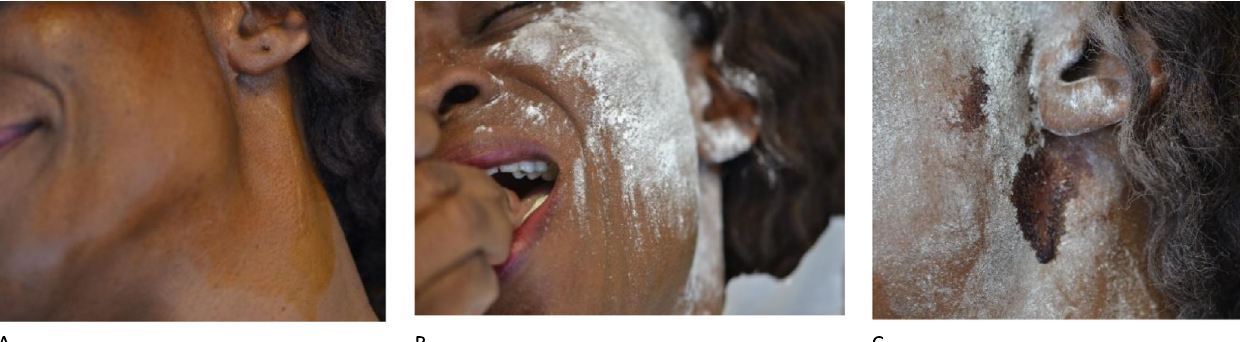
Fig. 5. A 36-year-old patient after total parotidectomy for a pleomorphic adenoma. Minor test, A: painting with Betadine®, B: starch and salivary stimulation and C: evidence of Frey ’ s syndrome (credit: Dr. Chikhani).